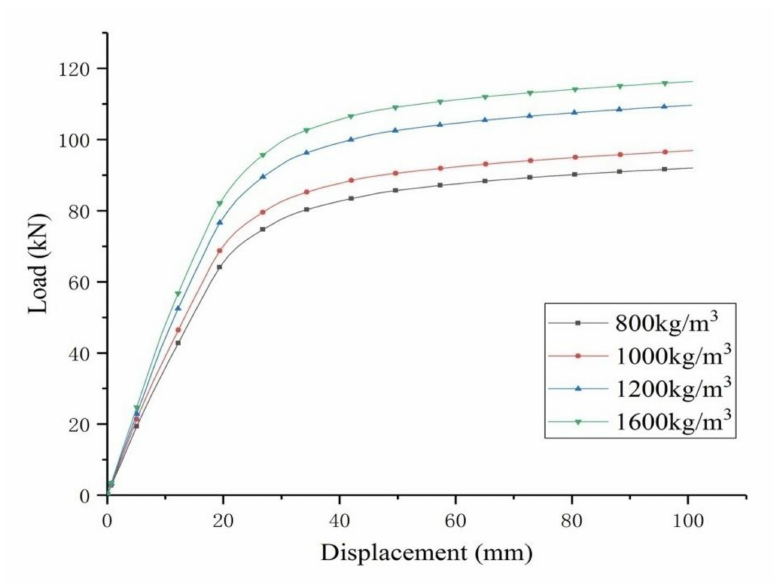
Figure 21. Load displacement curves of different grades of foam